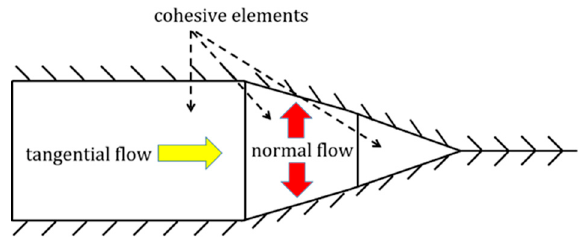
Figure 3. Flow of fracturing fluid within fracture.